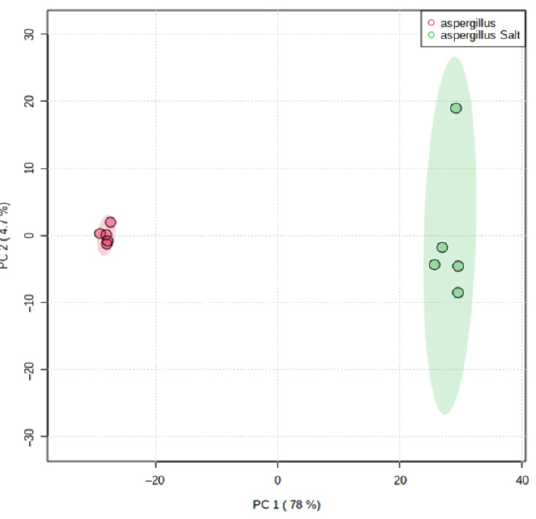
Figure 6. Principal Component Analysis (PCA) scores plot of salted and non-salted extracts of As- pergillus affinis CMG 70. Green represents salted extracts and in red non-salted extracts.